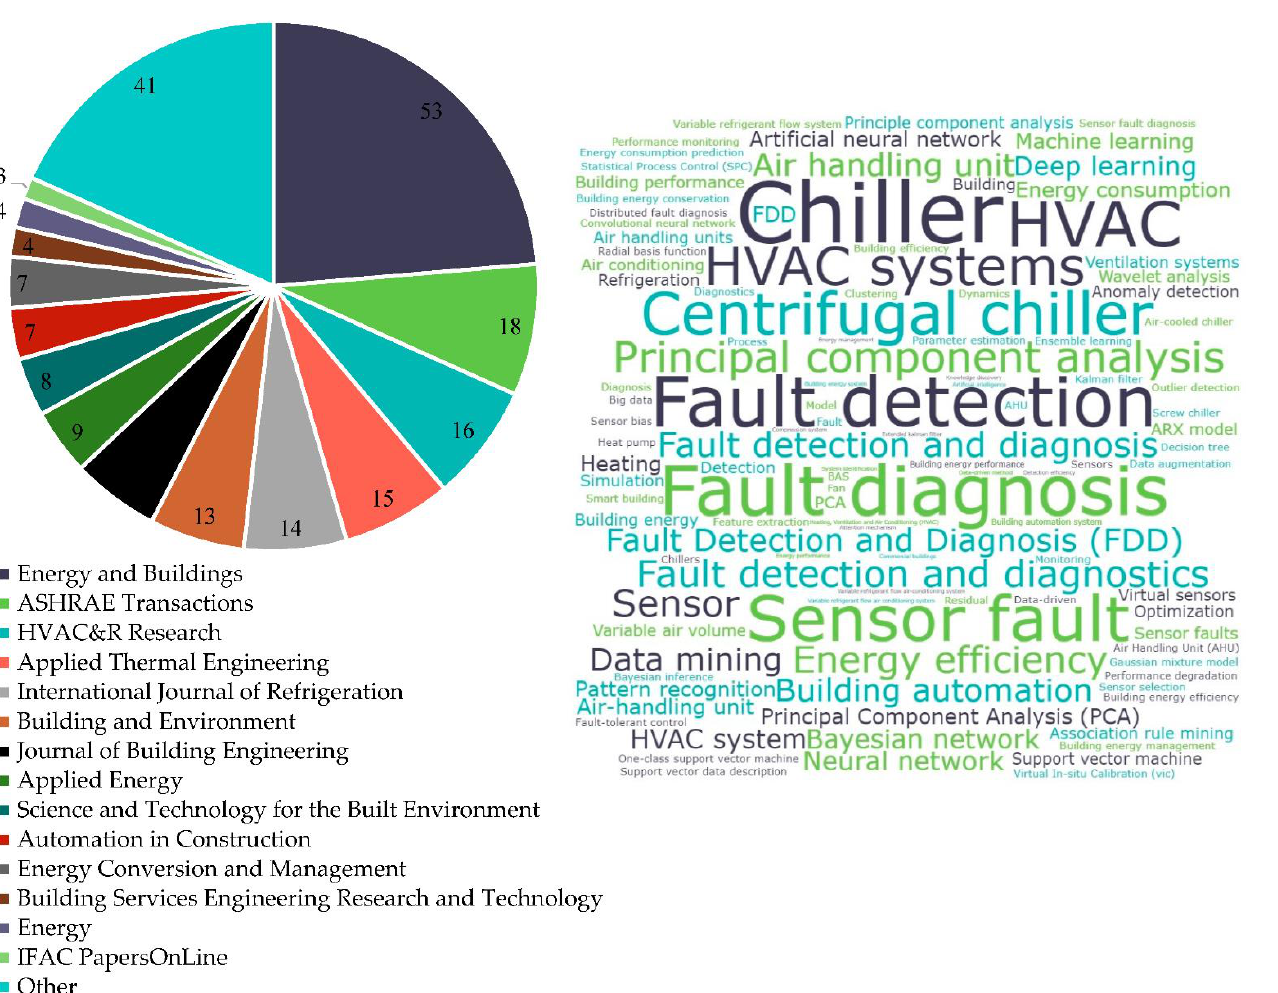
Figure 5. Authorship countries represented in the reviewed articles.